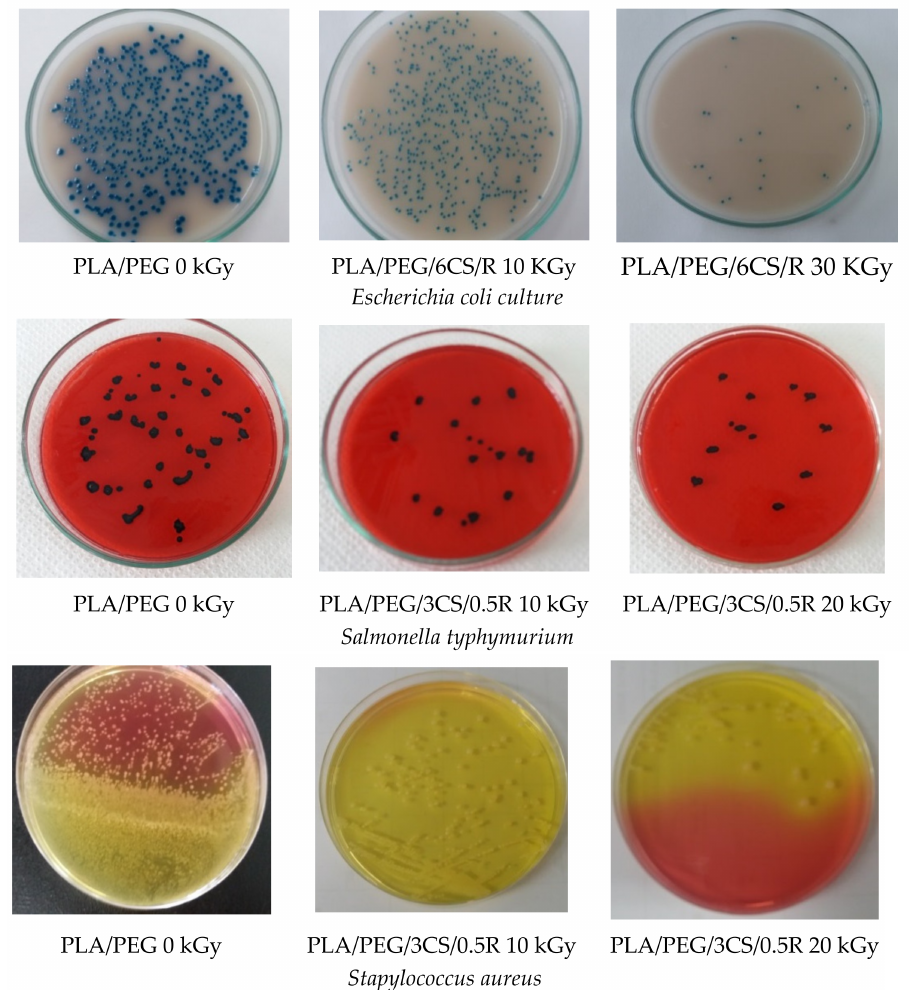
Figure 14. Microscopical aspects of the three bacterial cultures in the presence of PLA-based systems before and after